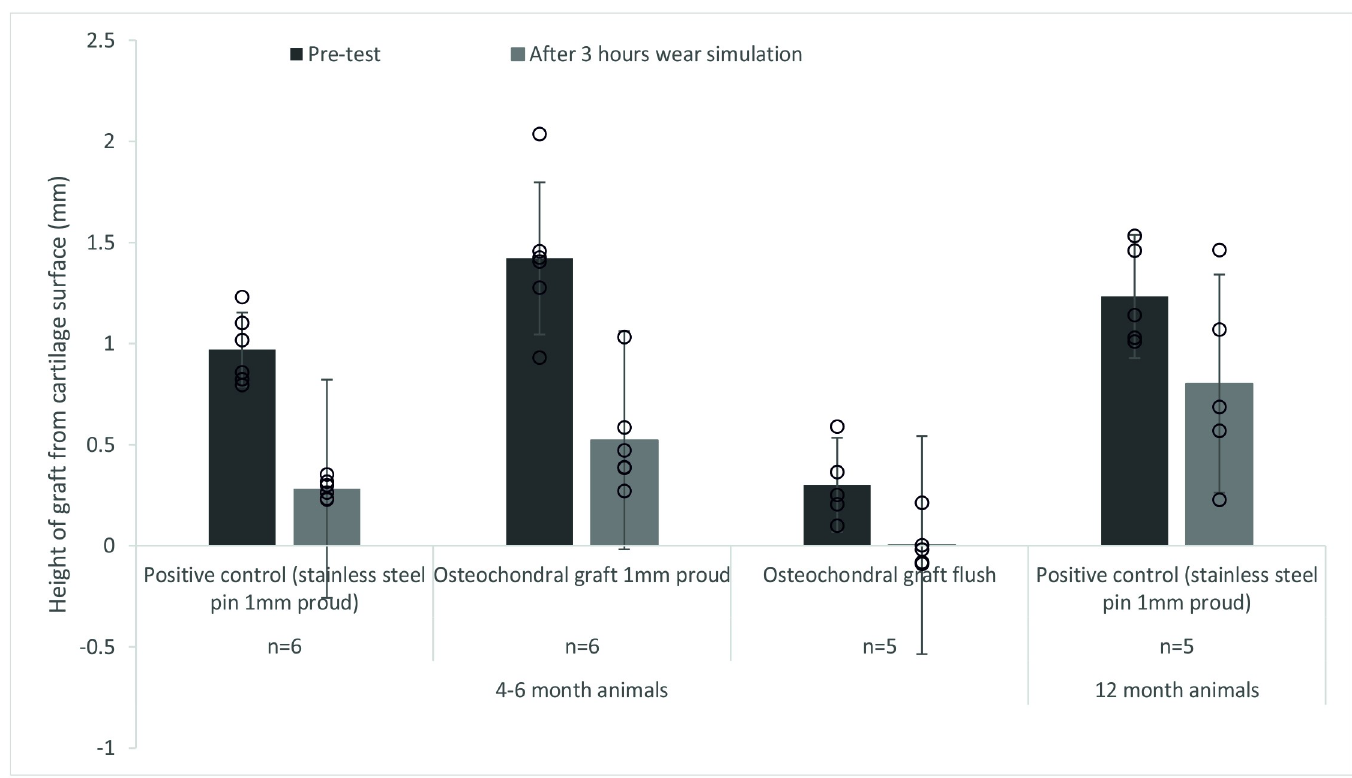
Fig 7. Mean ( ± 95% CL) protrusion of the pin/osteochondral graft from the cartilage surface (mm). A comparison between the protrusion of the pin prior to the start of the study and after 3 hours (10,800 cycles) of simulation under a walking gait cycle. The data points from all experimental groups have been overlaid as a dot